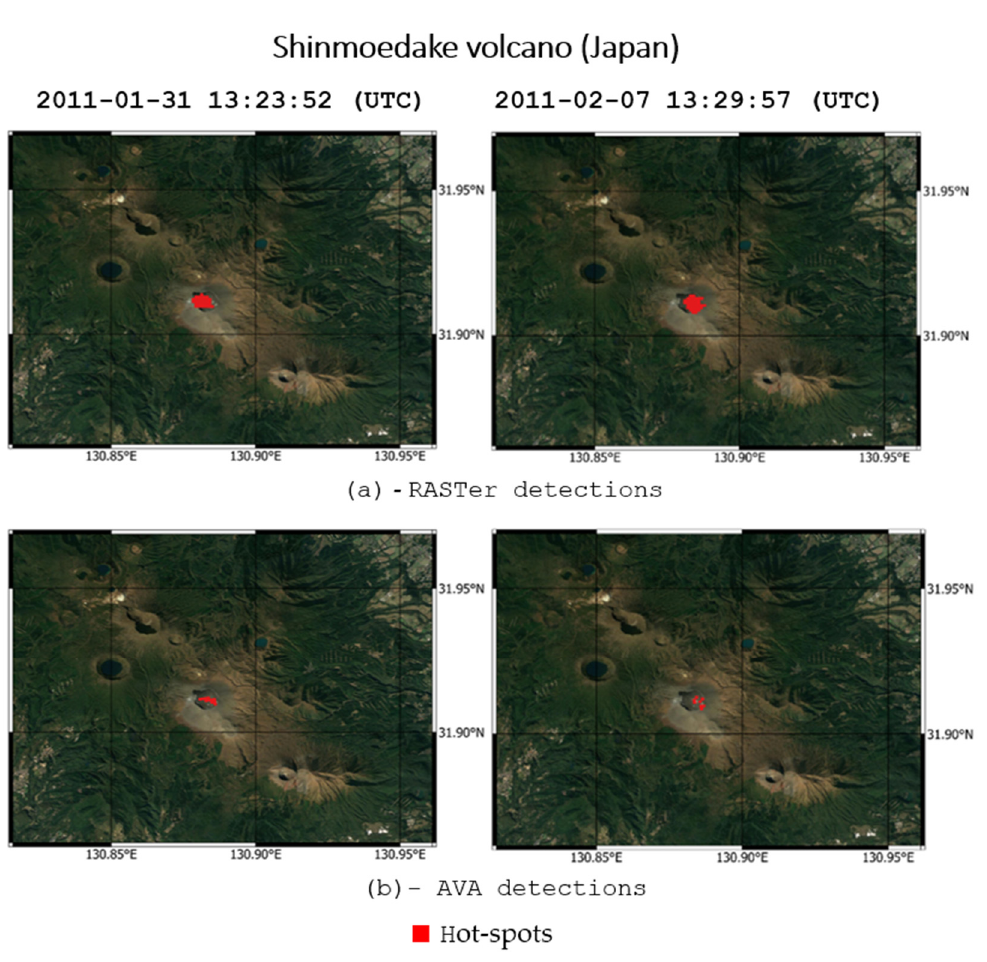
Figure 7. Thermal anomalies (red pixels) detected at Shinmoedake volcano on January–February 2011 ( a ) from RASTer; ( b ) from